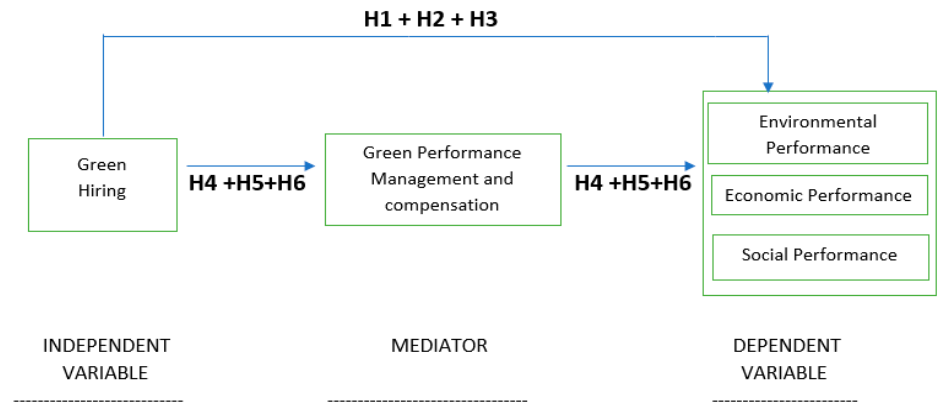
Figure 1. Conceptual